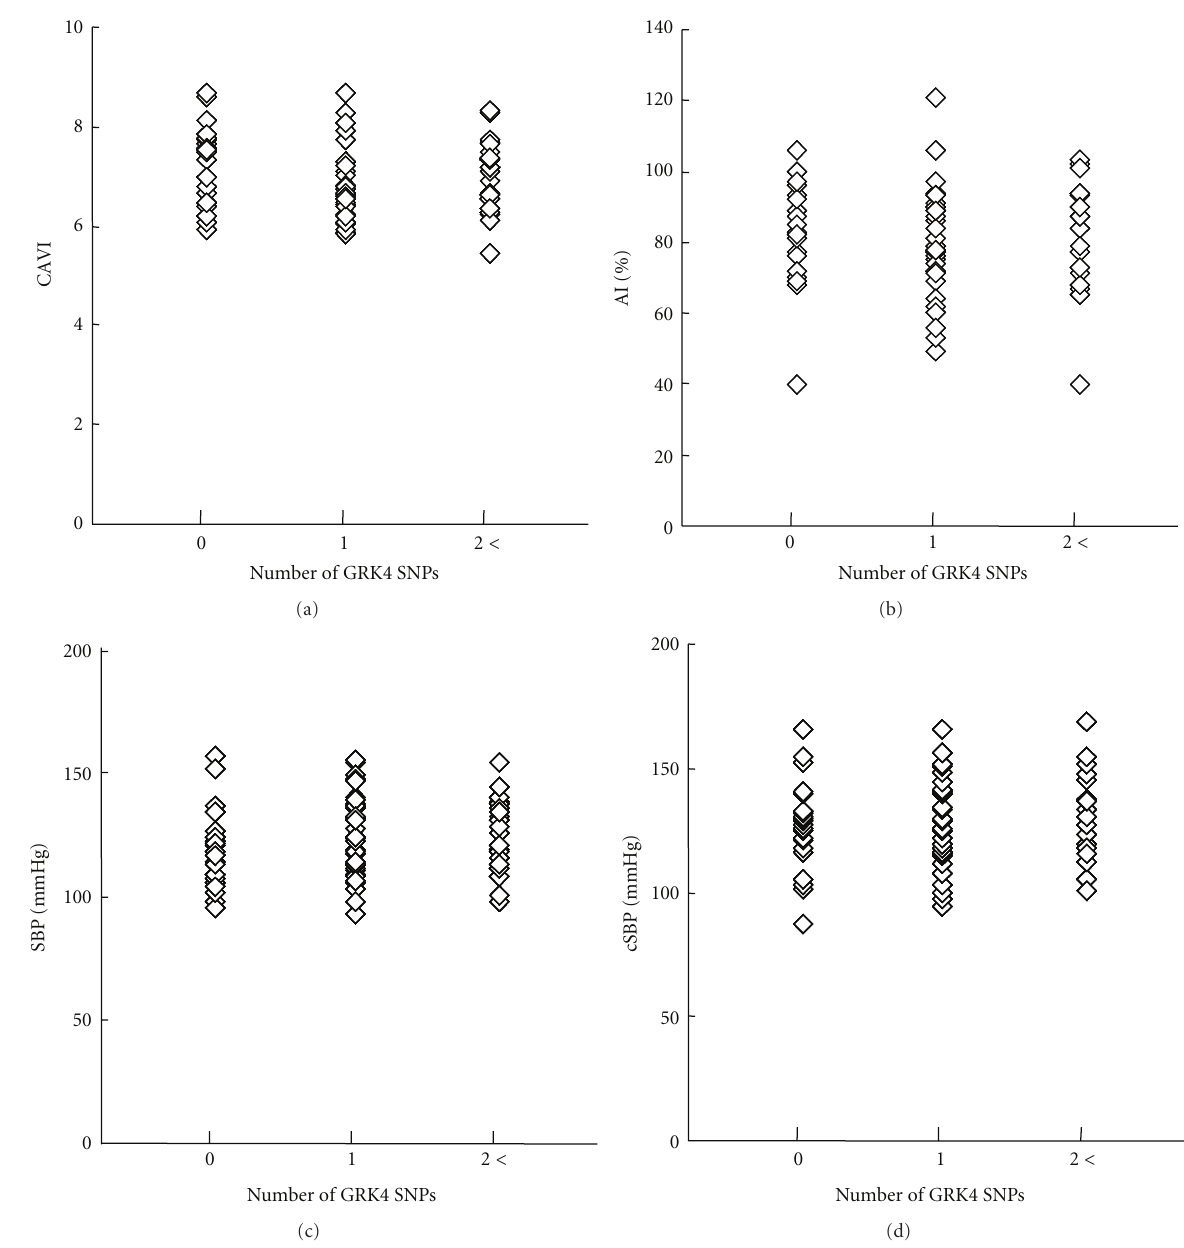
Figure 1: The relationships between number of GRK4 polymorphic alleles GRK4 (R65L, A142V, A486V—LL, VV, VV = 6 alleles) and (a) cardio-ankle vascular index (CAVI), (b) augmentation index (AI), (c) systolic blood pressure (SBP), and (d) central systolic blood pressure.